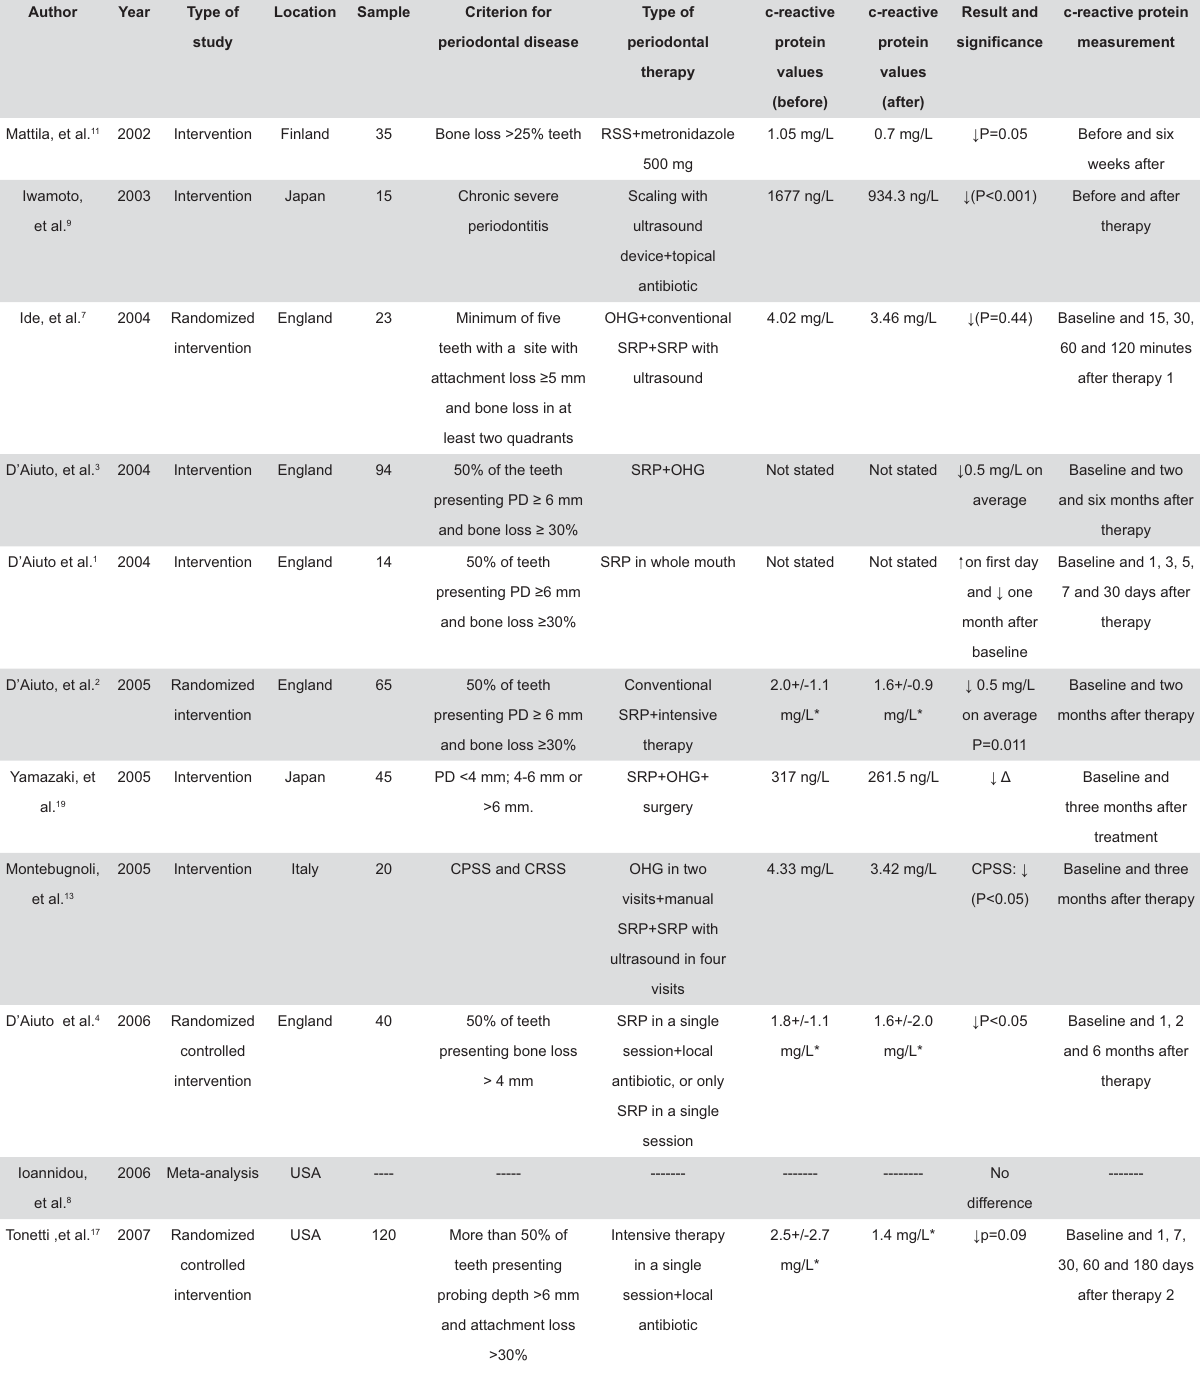
Figure 4- Schematic summary of published studies that evaluated the effect of periodontal therapy on the serum levels of C-reactive